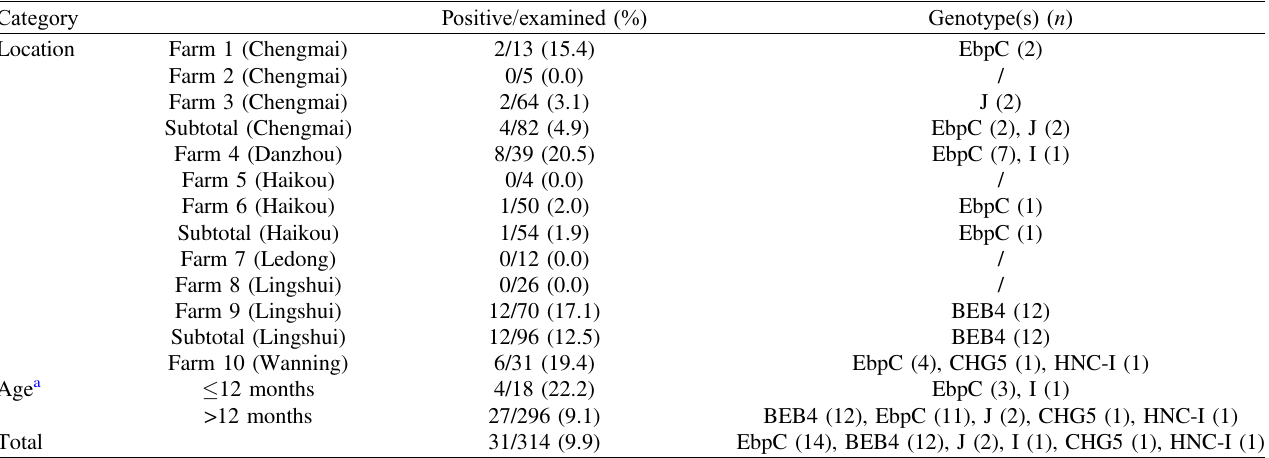
Table 2. Prevalence and genotype distribution of E. bieneusi isolates in cattle in Hainan Province. Category Positive/examined (%) Genotype(s) ( n )